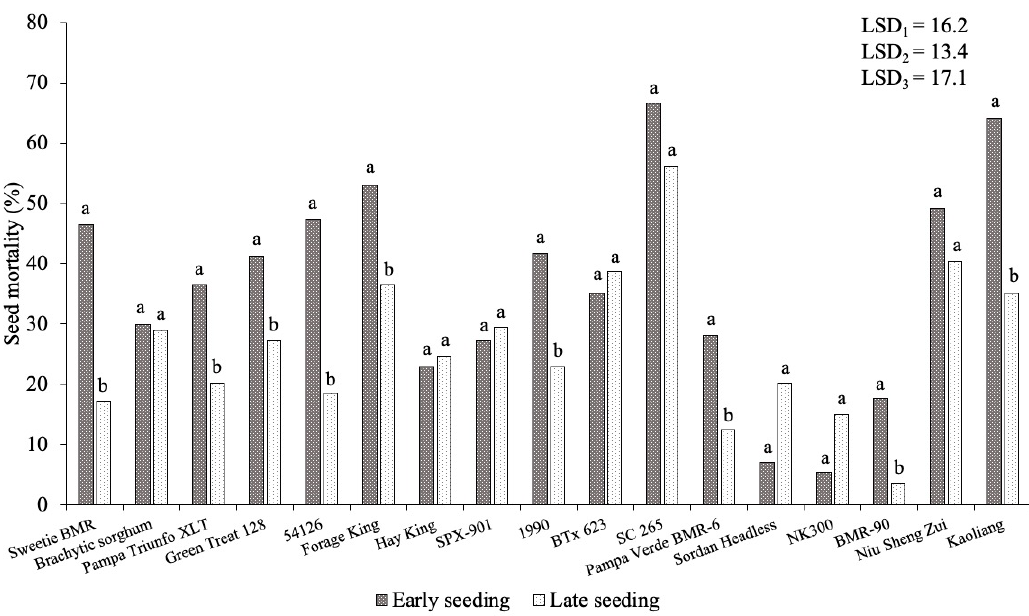
Figure 4. Mean seed mortality rate in forage sorghum genotypes planted on two seeding dates averaged across four environments at 20 days after each planting in Fargo and Hickson, ND, USA, in 2017 and 2018. Least significant differences (LSD 1 ) to compare among genotypes within the same seeding date, LSD 2 to compare same genotypes between different date and also different small case letters show significant differences, LSD 3 to compare among genotypes on different seeding date).